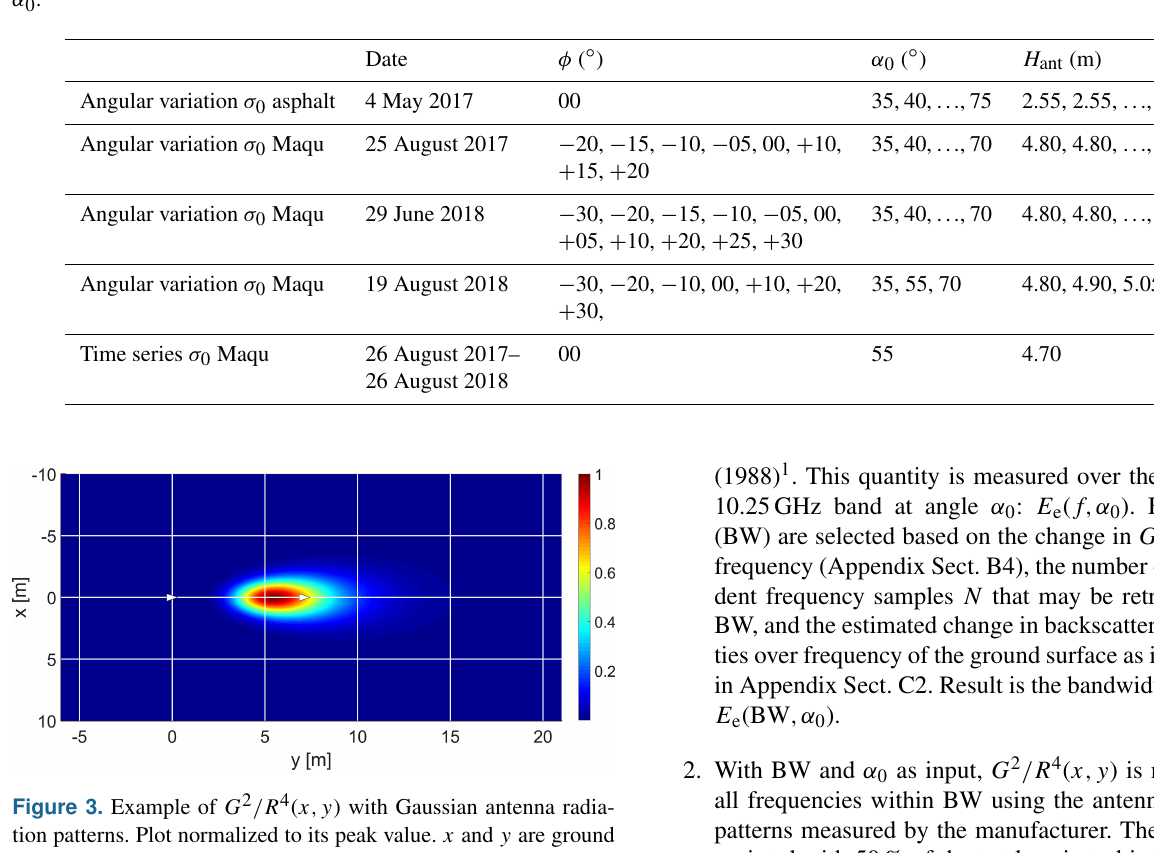
Table 1. Overview of performed scatterometer experiments and their respective α 0 and φ ranges. Antennae aperture height H ant depends on α 0 .